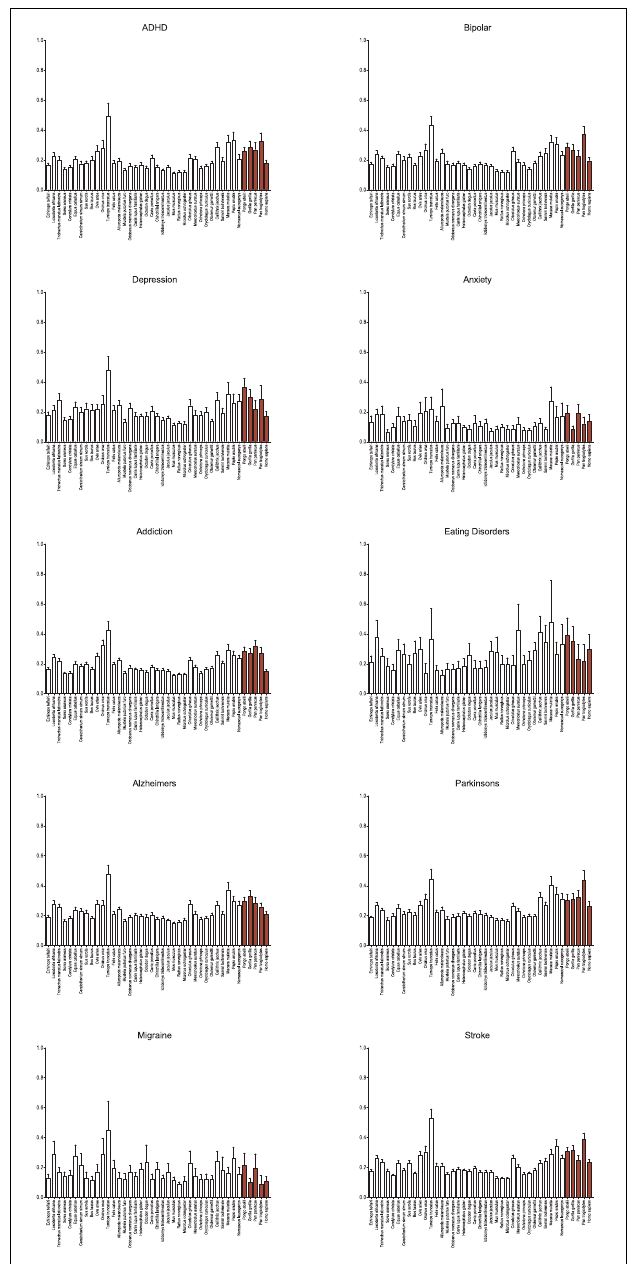
FIGURE 3 | Average d N /d S across taxa of genes associated with other neurological diseases and controls. Average d N /d S of genes positively associated with other neurological diseases (ADHD, bipolar disorder, depression, anxiety, addiction, eating disorders, Alzheimers, and Parkinsons, migraine) and control (stroke) based on positive gene-disease associations in the Genetic Association Database (GAD) are depicted. Average d N /d S ratios reveal a similar pattern of evolution in catarrhines and dophin as was seen with schizophrenia and autism, to the exclusion of anxiety, eating disorder, and migraine which depict broad evolutionary conservation across all evaluated mammalian taxa. Pairwise significance values are shown in Supplemental Table 4.